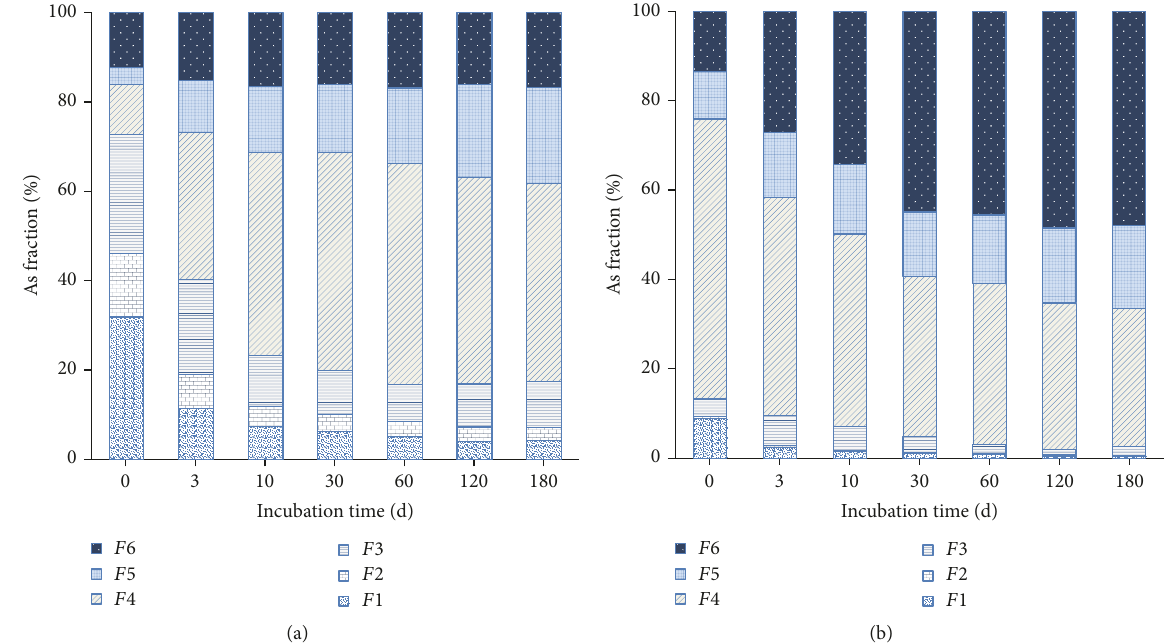
Figure1:ThefractionsofAsinirongritamendedandunamendedsoilsatdifferenttimeundertheanoxiccondition((a)S N ,(b)S IN ; 𝐹1 —water soluble fraction, 𝐹2 —exchangeable fraction, 𝐹3 —loosely adsorbed fraction, 𝐹4 —strongly adsorbed and organically bound fraction, 𝐹5 —Fe and Mn/Al oxides bound fraction, and 𝐹6 —residual fraction).